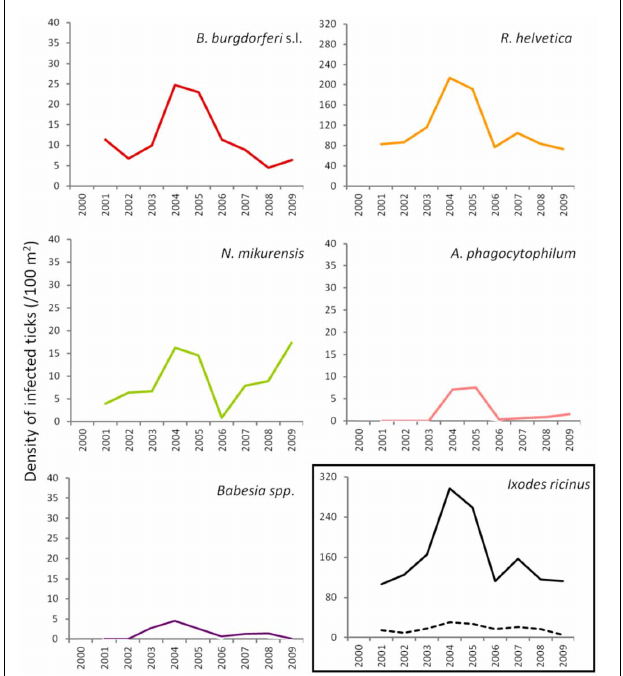
FIGURE 5 | Changing average (2 years) of density of infected ticks and tick density/activity in Duin&Kruidberg area. Density/activity of nymphs and adults are shown in the bottom right graph as continuous and dotted line, respectively.